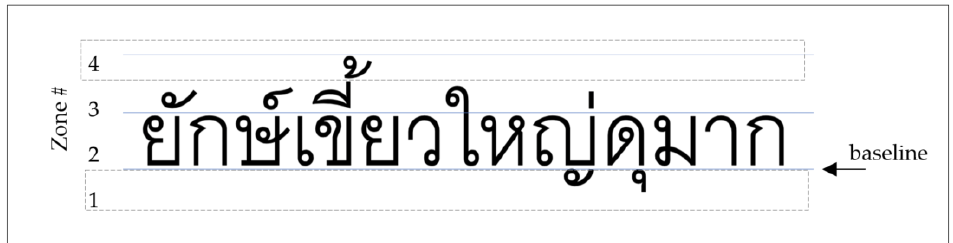
Figure 1. The Thai sentence in four‑line zones style.